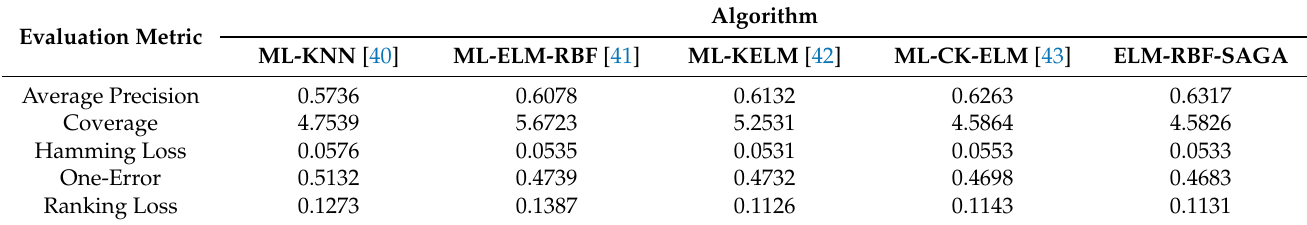
Table 5. Performance of different models in the art dataset.